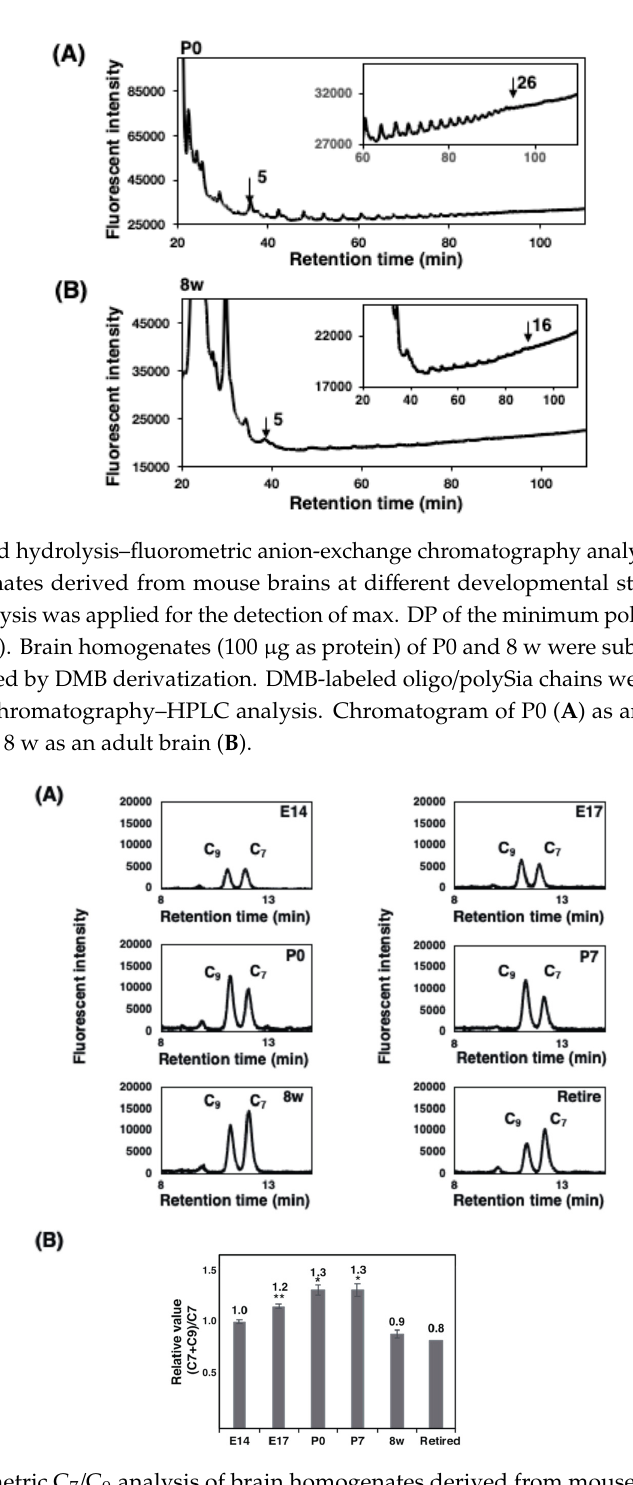
Figure 7. Fluorometric C 7 /C 9 analysis of brain homogenates derived from mouse brains at different developmental stages. The fluorometric C 7 / C 9 method was applied to analyze average DP. Brain developmental stages. The fluorometric C 7 /C 9 method was applied to analyze average DP. Brain homogenates (20 µ g as protein) of six di ff erent developmental brains were used for the analysis ( n = 3). homogenates (20 μ g as protein) of six different developmental brains were used for the analysis ( n = (A) Typical chromatograms of C 7 / C 9 analysis of each brains. ( B ) (C 7 + C 9 ) / C 7 index in each brain. 3). (A) Typical chromatograms of C 7 /C 9 analysis of each brains. ( B ) (C 7 + C 9 )/C 7 index in each brain. * p < 0.05. ** p < 0.01. * p < 0.05. ** p <